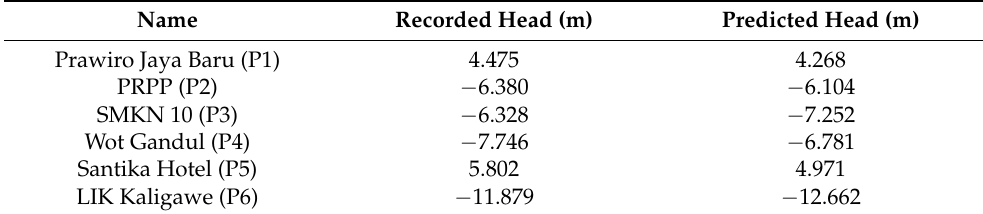
Table 2. Results of the steady-state flow simulation.